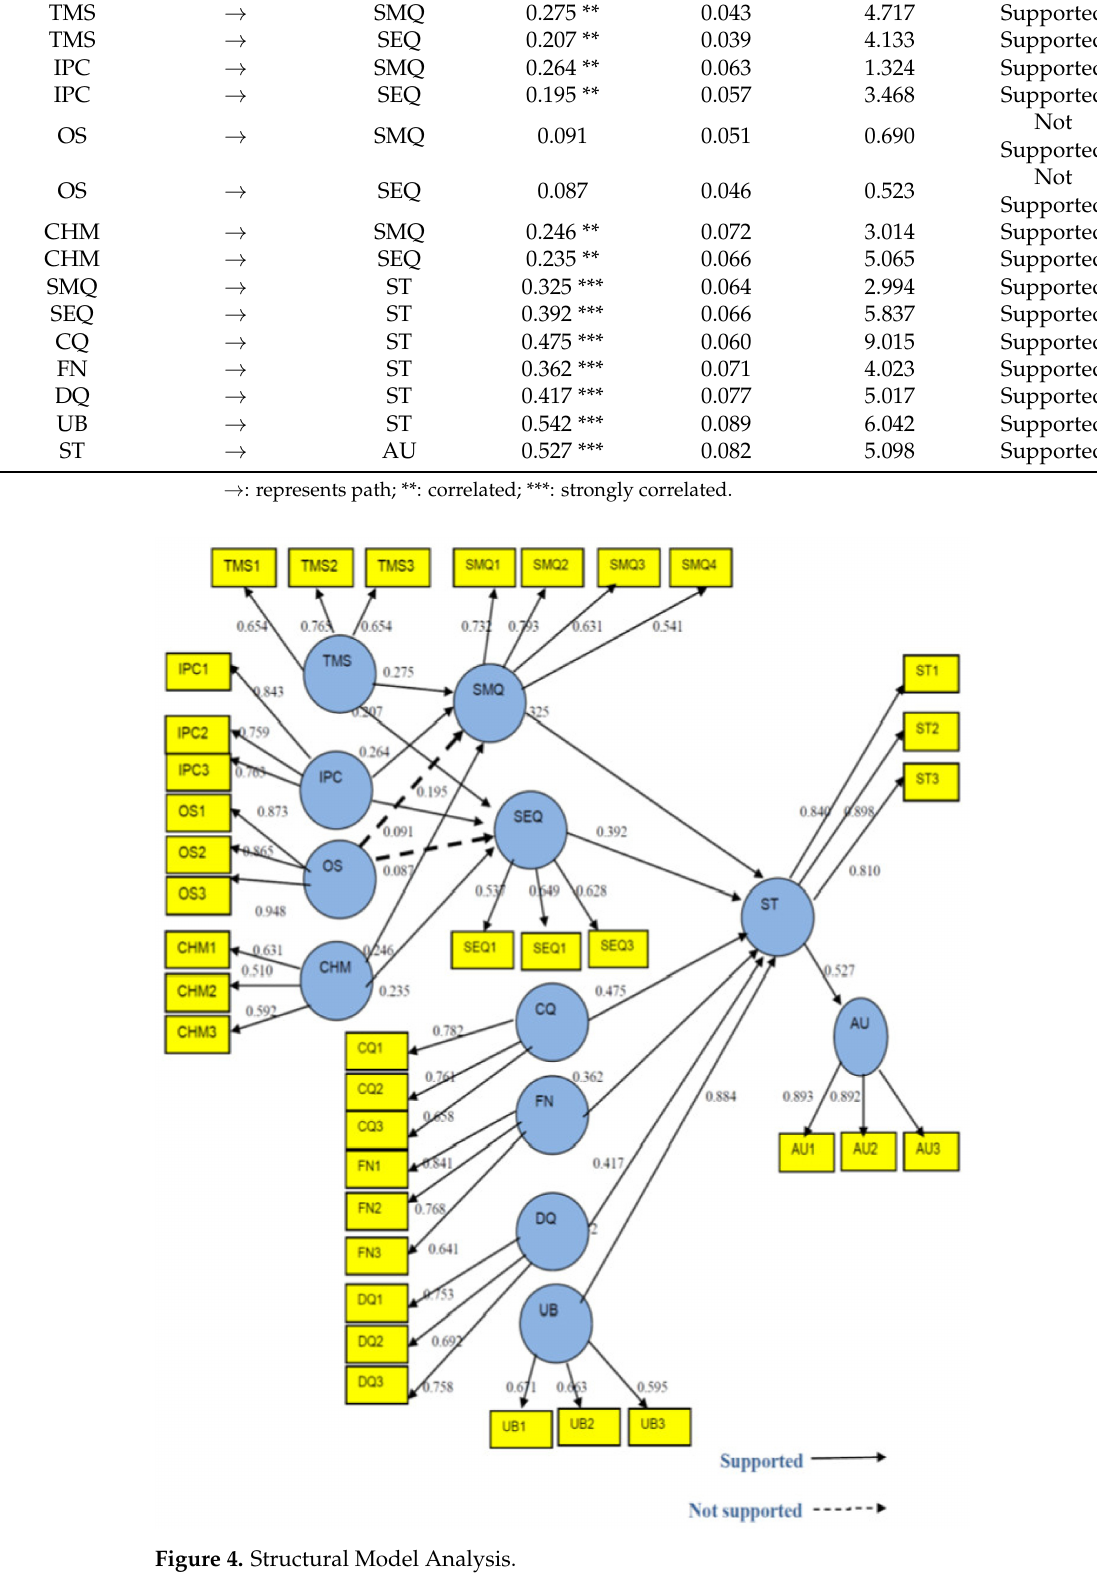
Figure 4. Structural Model